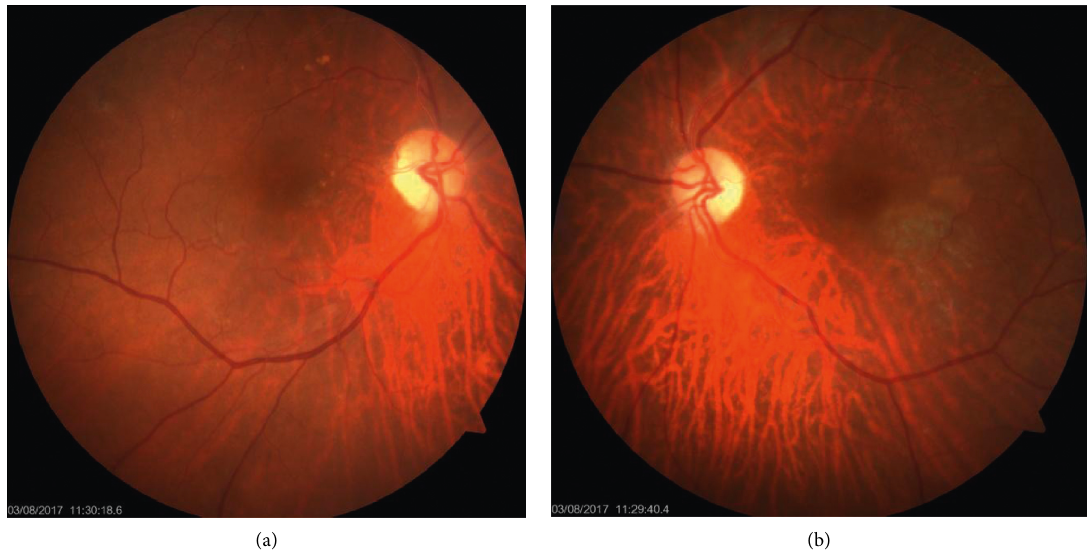
Figure 1: Fundus photograph of the right (a) and left (b) eyes. The right eye shows a pale disc, and the left eye shows a pale disc and cherry red